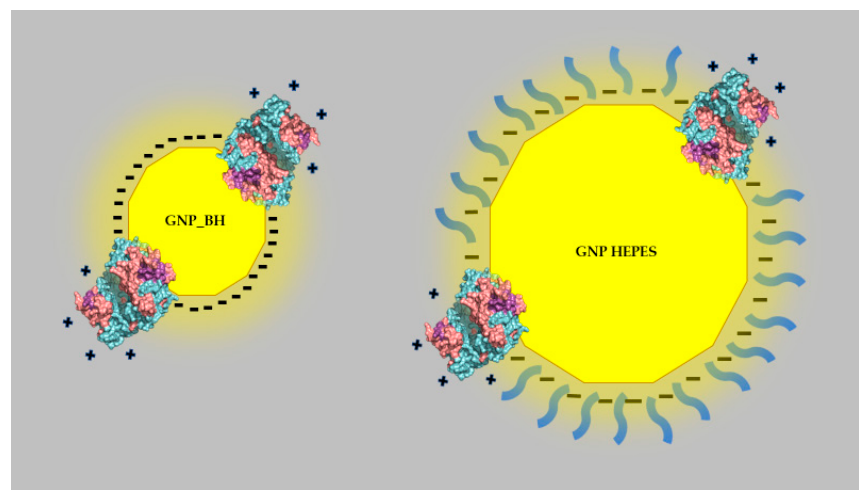
Figure 6. Cartoon representative of a putative effect of nanoparticle size on the zeta potential promoted by the adsorption of the proteases.